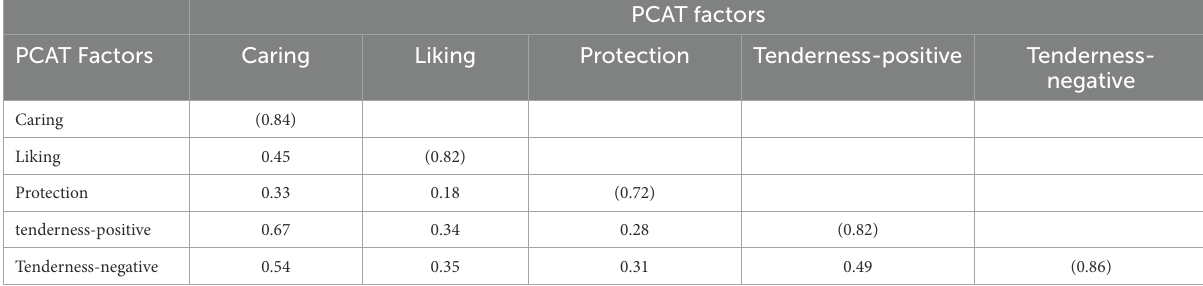
TABLE 2 Correlation between the 5 factors and internal reliabilities (Cronbach’s alpha within parentheses on the diagonal).